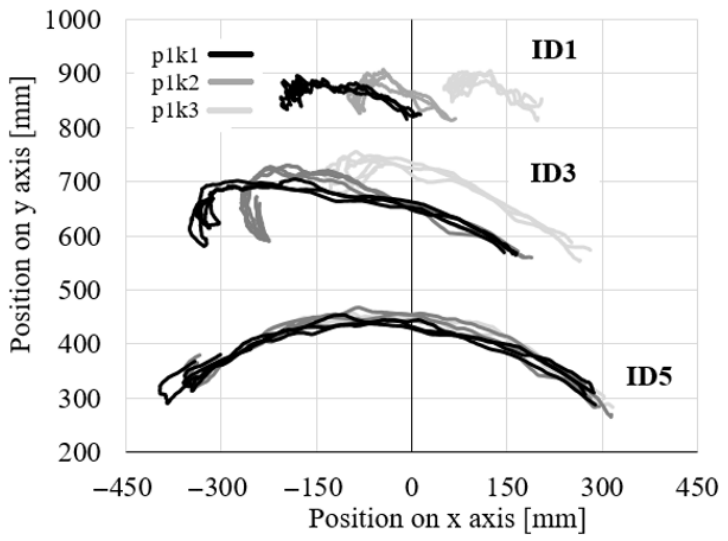
Figure 11. The displacement of individual markers for a constant gear ratio and a variable inclination angle of the wheelchair.